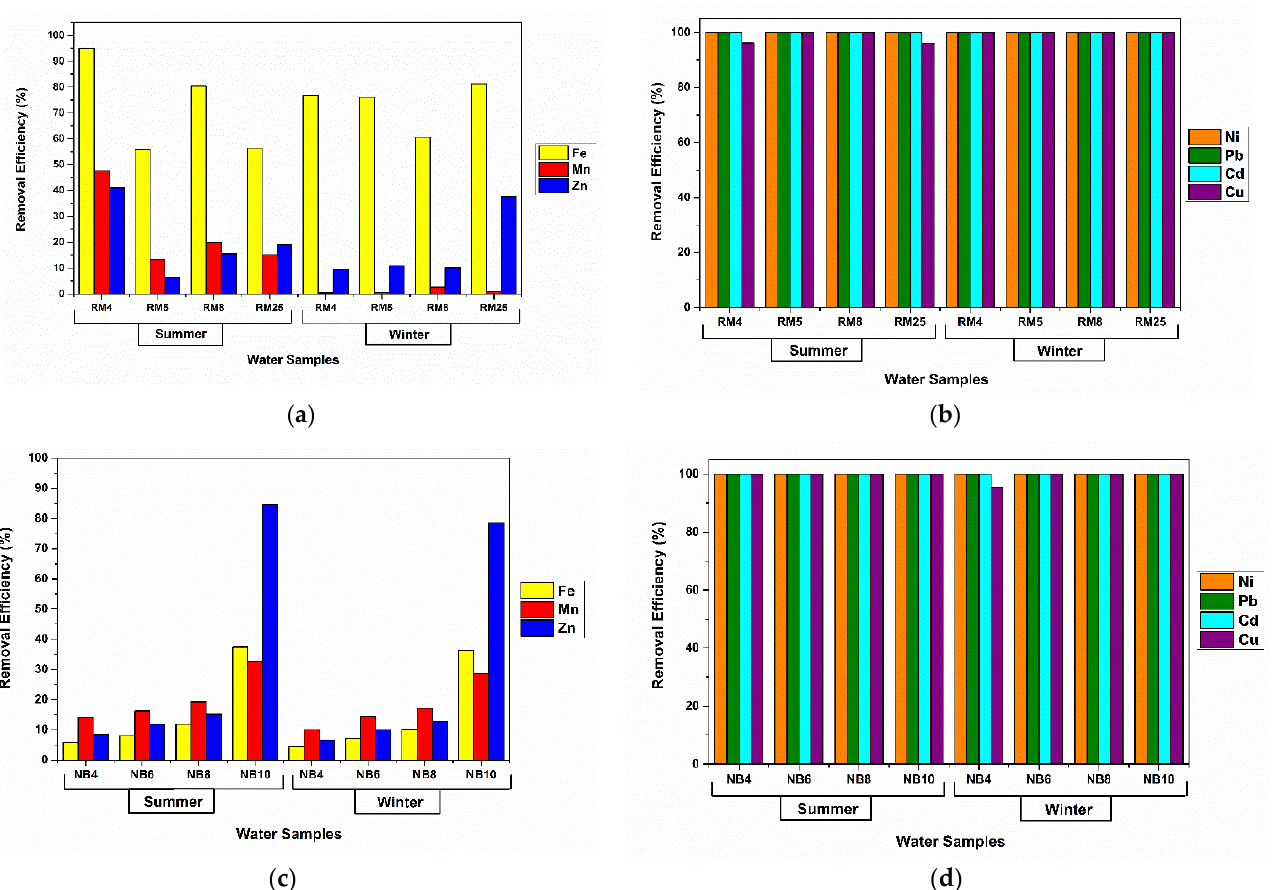
Figure 17. CHIT-PAAA removal efficiencies for heavy metals in water samples from ( a , b ) Ro ș ia Montan ă and ( c , d ) Nov ăț -Bor ș a mining areas, Romania.